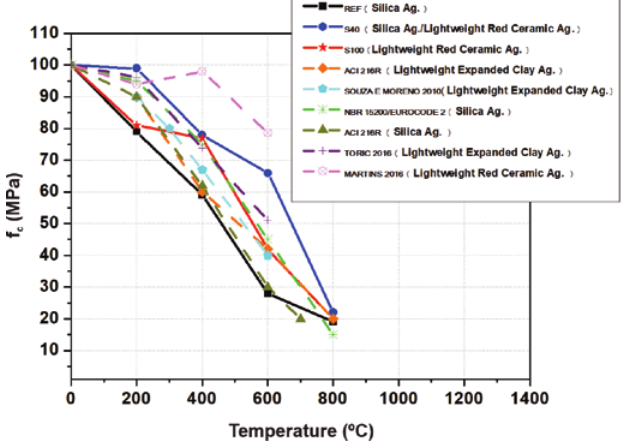
Reduction values of the axial compressive strength of concrete mixtures with substitution percentages of 0%, 40% and 100%